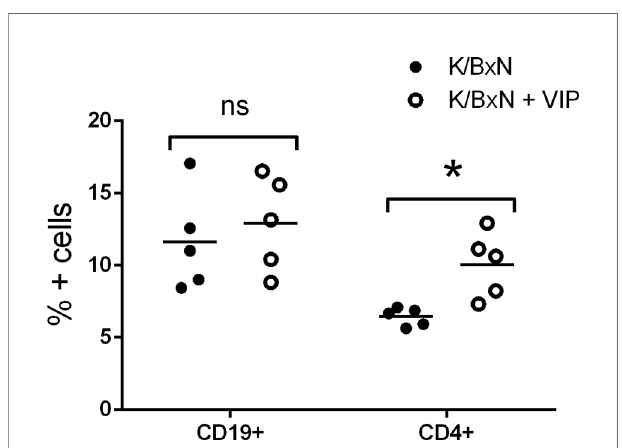
FIGURE 3 | Flow cytometry analysis of spleen lymphoid cells of K/BxN mice treated with PBS or VIP. Mean is shown as the horizontal line within each group; each symbol represents an individual mouse. *p < 0.05.